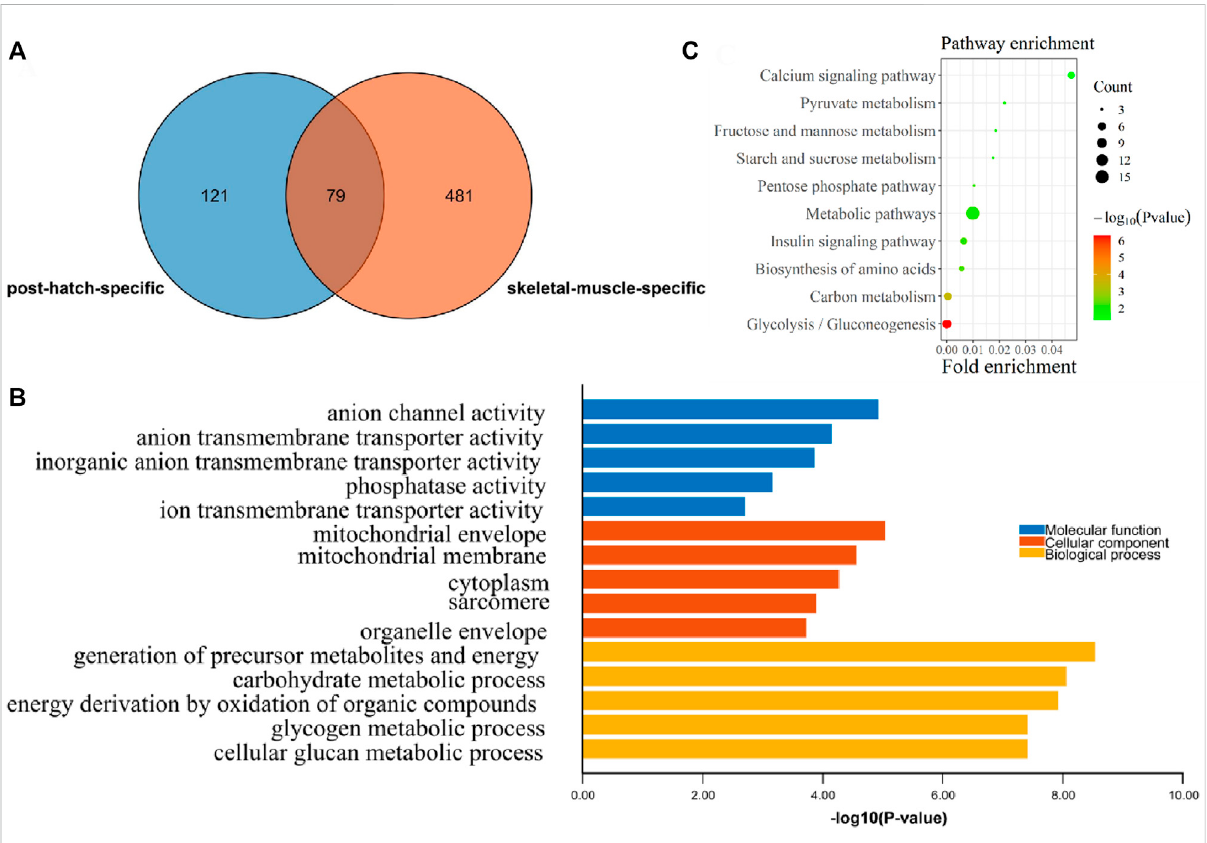
FIGURE 4 Functional enrichment analysis of postnatal muscle-speci fi c highly expressed genes. (A) Overlapping DEGs between the postnatal-speci fi c high-expressed gene set and the muscle-speci fi c high-expressed gene set; (B) GO enrichment analysis results of postnatal muscle-speci fi c highly expressed genes; and (C) KEGG enrichment analysis results of postnatal muscle-speci fi c highly expressed